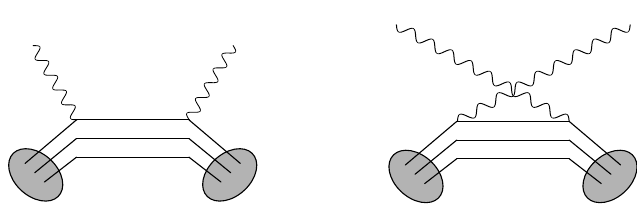
Figure 6 . These diagrams show the annihilation of two composite fermions (three solid lines) into two SM gauge bosons (two wave